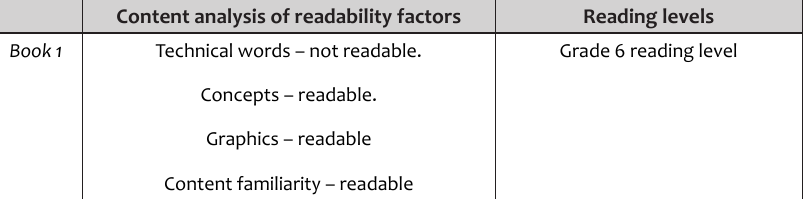
Table 5: Summary of readability ratings from content analysis and readability